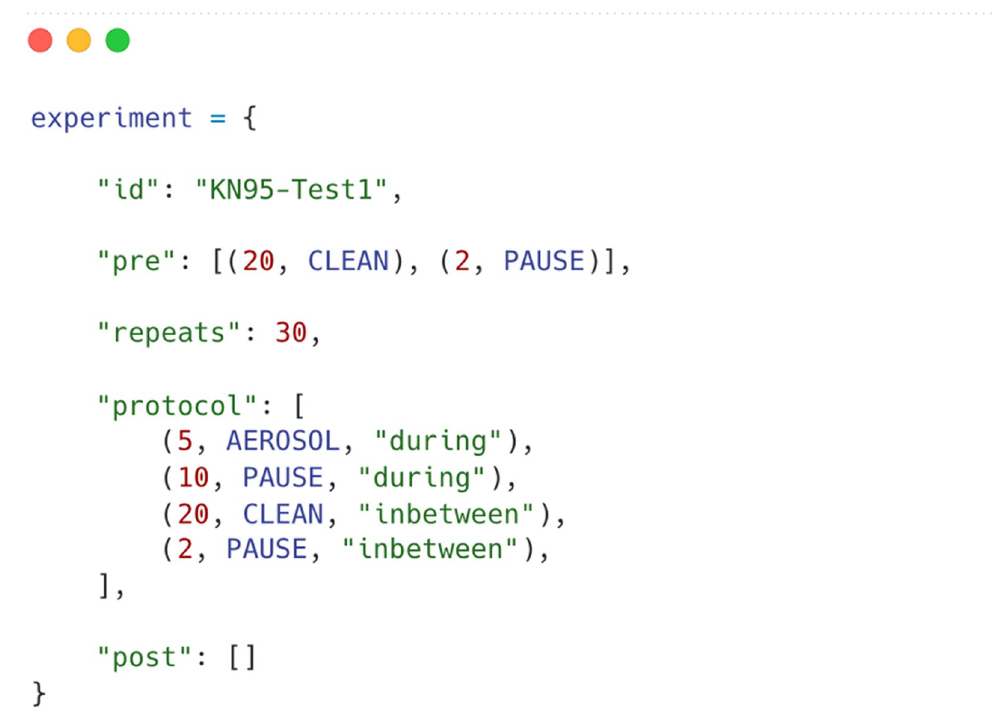
Figure 2. Configuration file for experiments. Explanation of Python file elements: “id” identifies the data uniquely. “pre” are actions run once before the experiment starts. “repeats” is how many times the experiment runs. “protocol” contains the sequential steps that are performed for the experiment. “post” contains actions that are performed once after the experiment finishes. The notation (20, AEROSOL, “during”) specifies that aerosol should be generated for 20 min. “during” is a comment that is added to the CSV data file. Similarly, CLEAN turns the air purifier on, and PAUSE does nothing except continue to collect data. Measurements are made every 6 s automatically and don’t have to be